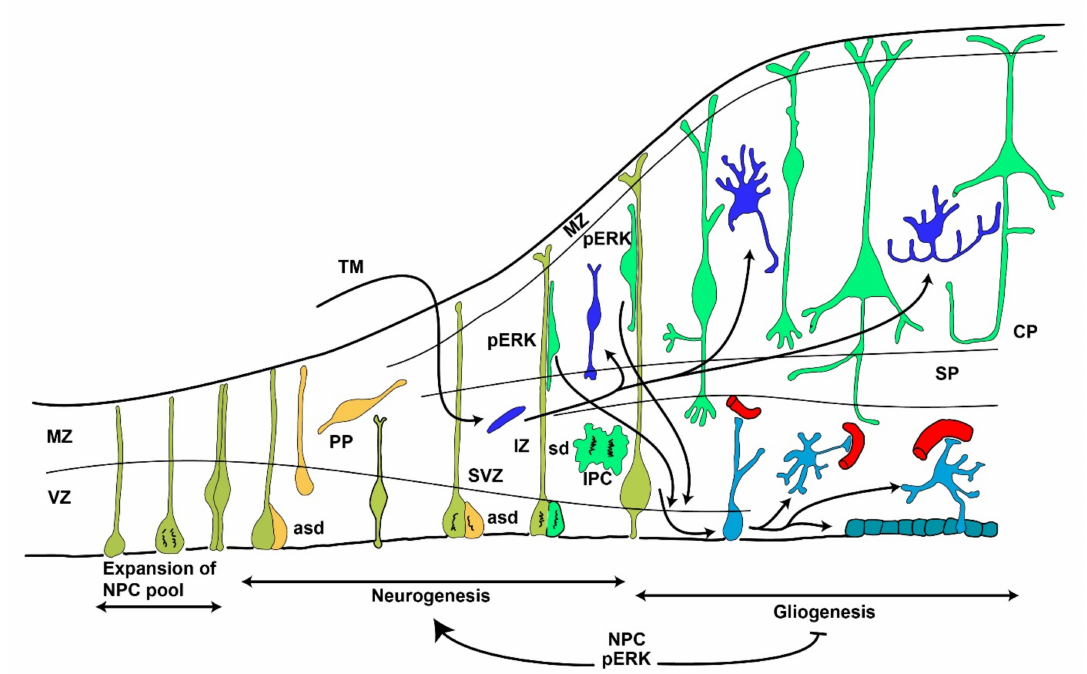
Figure 3. Scheme showing the development of the cerebral cortex and the role that MAPK / ERK signaling may have at di ff erent stages. Three main stages can be defined. The first stage is characterized by continuous divisions resulting in the expansion of the neural progenitor cell (NPC) pool. Starting at E11 until E17, the neurogenesis process is driven by ERK phosphorylation in the NPC, which suppresses gliogenesis. During neurogenesis, two kinds of divisions can be seen, i.e., asymmetric divisions (asd) and symmetric divisions (sd). Neuronal progenitors resulting from asd can derive intermediate progenitor cells (IPC) which divide in sd and cells resulting from these divisions migrate along the shafts of radial glia to the final fate. Inhibitory neurons in the cerebral cortex arise from tangential migration (TM) from the ganglionic eminences. Immature neurons produce signaling trophic factors mediated by MAPK / ERK signaling which induce gliogenesis, resulting in the generation of the di ff erent types of astrocytes. Throughout brain development, the cortex becomes layered from an initial period only composed of the ventricular zone (VZ) and the marginal zone. Then, newly born neurons are located in an intermediate layer that originates from the preplate (PP), which di ff erentiates into the subventricular zone (SVZ), intermediate zone (IZ), and subplate (SP). Then, the area containing the neuronal bodies of neurons makes the cortical plate. Modified from